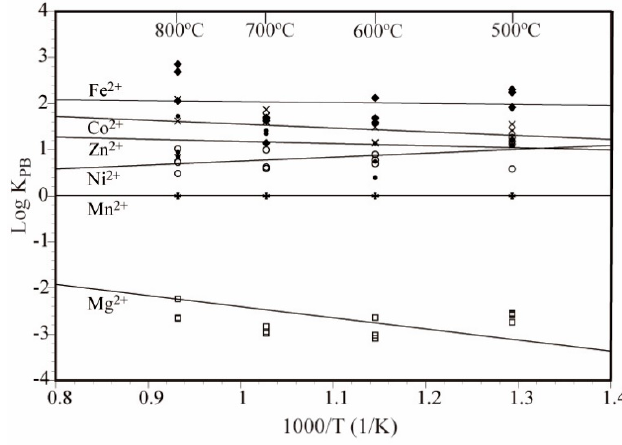
Figure 4. Temperature dependence of the partition coefficient K PB in the MnS–(Ni, Mg, Co, Zn, Fe)Cl 2 –H 2 O system. The temperature dependence lines in the figure were obtained using a least squares method.